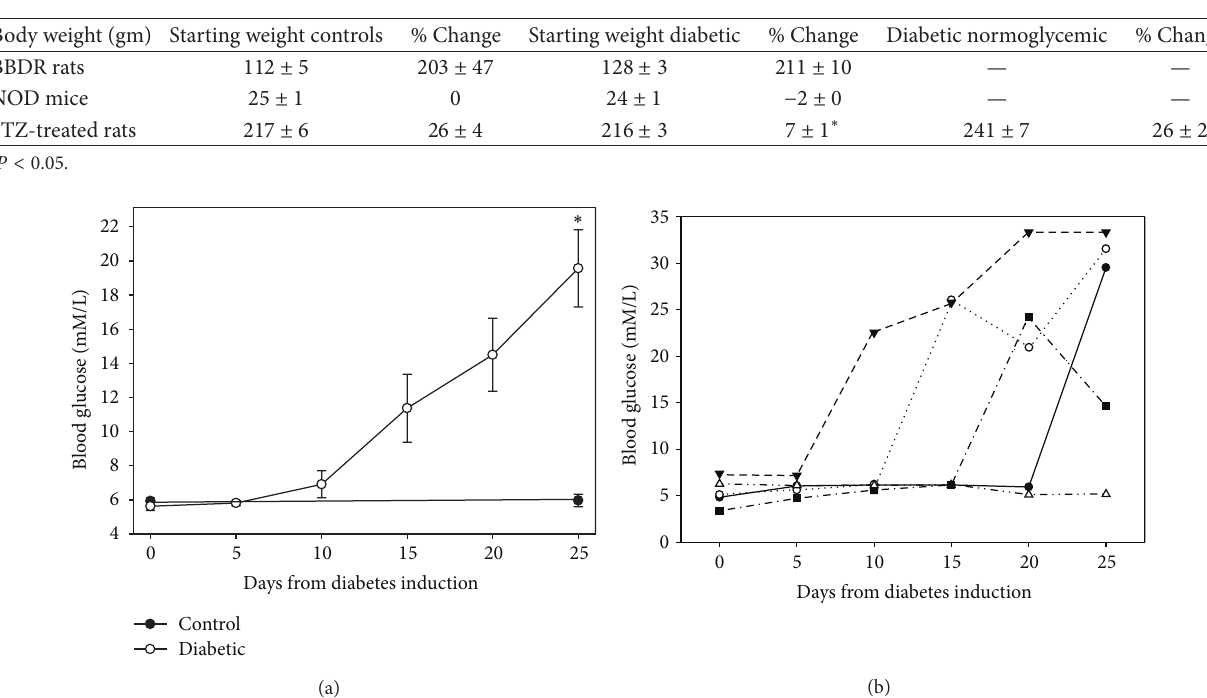
Figure 1: Blood glucose levels of BBDR rats. (a) Following induction of diabetes, average blood glucose levels gradually increased over the next 25 days but remained constant in controls ( ∗ = 𝑃 < 0.001 ). (b) In analyzing the progression of diabetes in the individual animals, the onset of hyperglycemia varied by 15 days. Each line follows the blood glucose level for an individual rat chosen to demonstrate the variation in diabetes